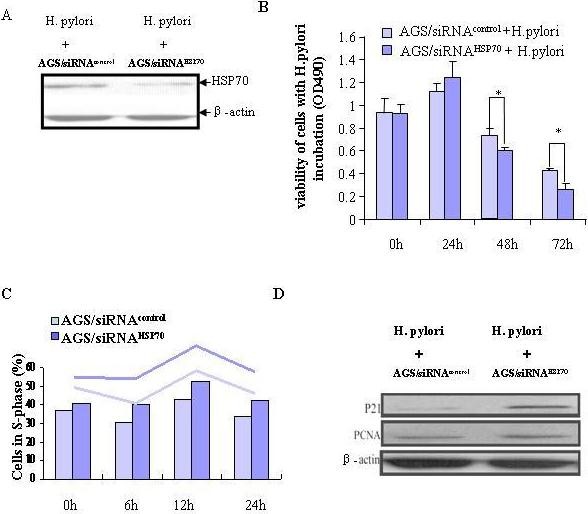
HSP70 depletion enhanced inhibition of proliferation in AGS cells with H. pylori infection. (A) Aberrant expression of HSP70 in transfected AGS cells with H. pylori infection was evidenced by immunoblotting. (B) HSP70 suppression further aggravated inhibitory role of H. pylori in cell viability in AGS cells. Data are mean ± SD, *P <0.05. (C)The effect of HSP70 depletion on proliferation was further confirmed by flow cytometre, which showed more accumulation of HSP70 siRNA transfected cells in S-phase as compared with the control vector transfected cells. (D) Protein expression of p21 and PCNA was evaluated by immunoblotting. β-actin was used as an internal control.